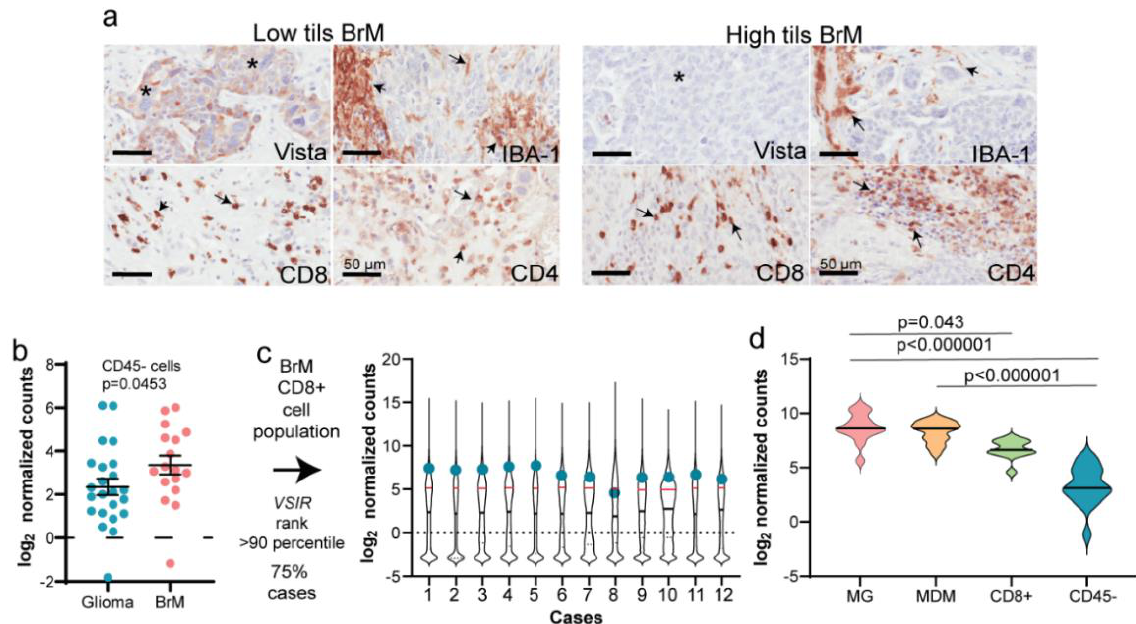
Figure 5. VISTA expression analysis using single IHC, as well as RNA analysis, in the Klemm dataset. ( a ) Representative images of standard IHC staining on BrMs sections with * representing tumor cells and arrows indicating positive staining. ( b ) VSIR gene expression in BrMs and gliomas within CD45- population in the Klemm RNAseq dataset [12]; ( c ) ranking of VSIR in CD8+ population within BrM cases; ( d ) within BrMs expression levels of VSIR in Microglial (MG), monocyte-derived macrophages (MDMs), CD8+ and CD45- populations.